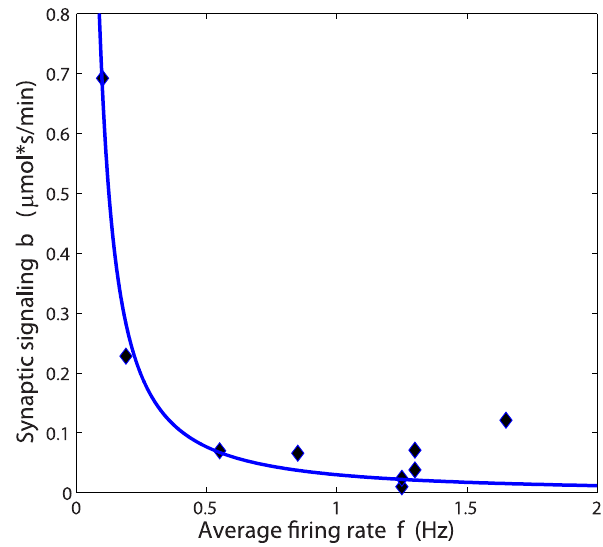
Figure 4. Inverse relationship between synaptic signaling and average firing rate across mammals. Values of the synaptic efficacy b and firing rates f (arithmetic means) were found by fitting experimental data to the theoretical model (Table 4). Note that all data points (diamonds) coming from different species and cortical regions align into a universal curve of the form: b ~ 0 : 03 f { 1 :